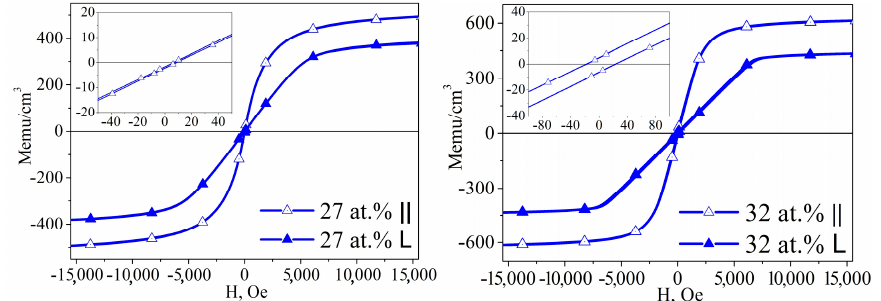
Figure 5. The M–H loop for NC Co 32 (MgF 2 ) 68 and for NC Co 27 (MgF 2 ) 73 , where the solid delta shows loop.